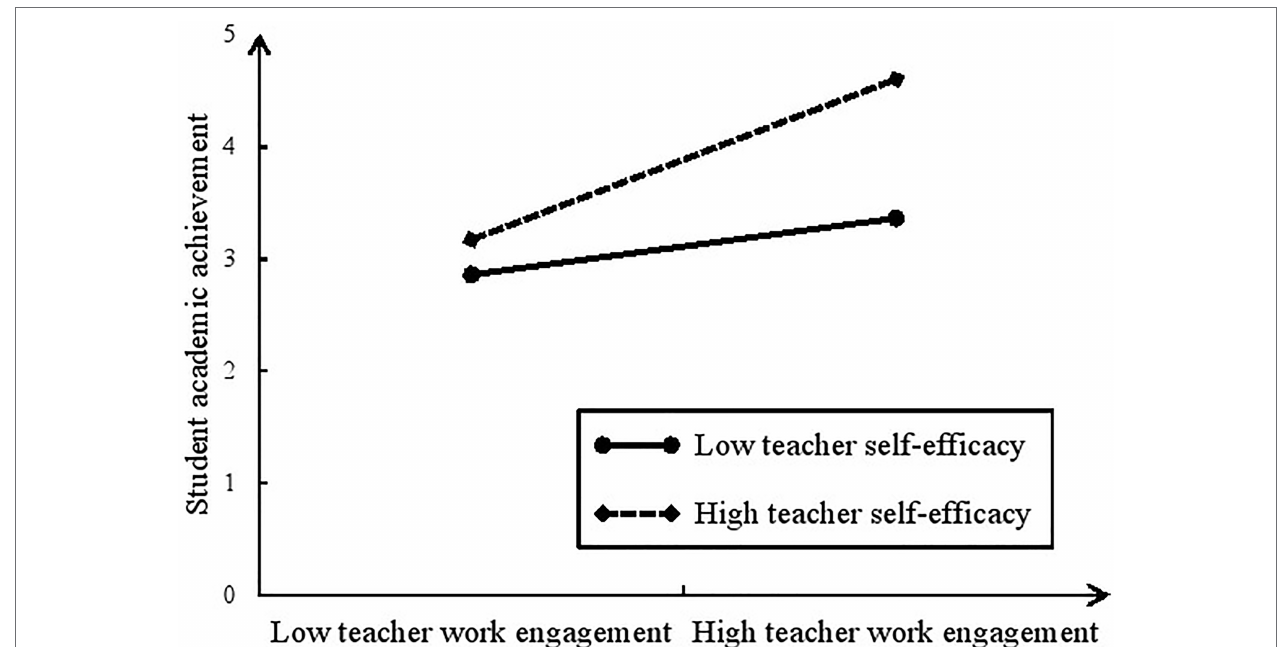
FIGURE 1 | The moderating effect of teacher